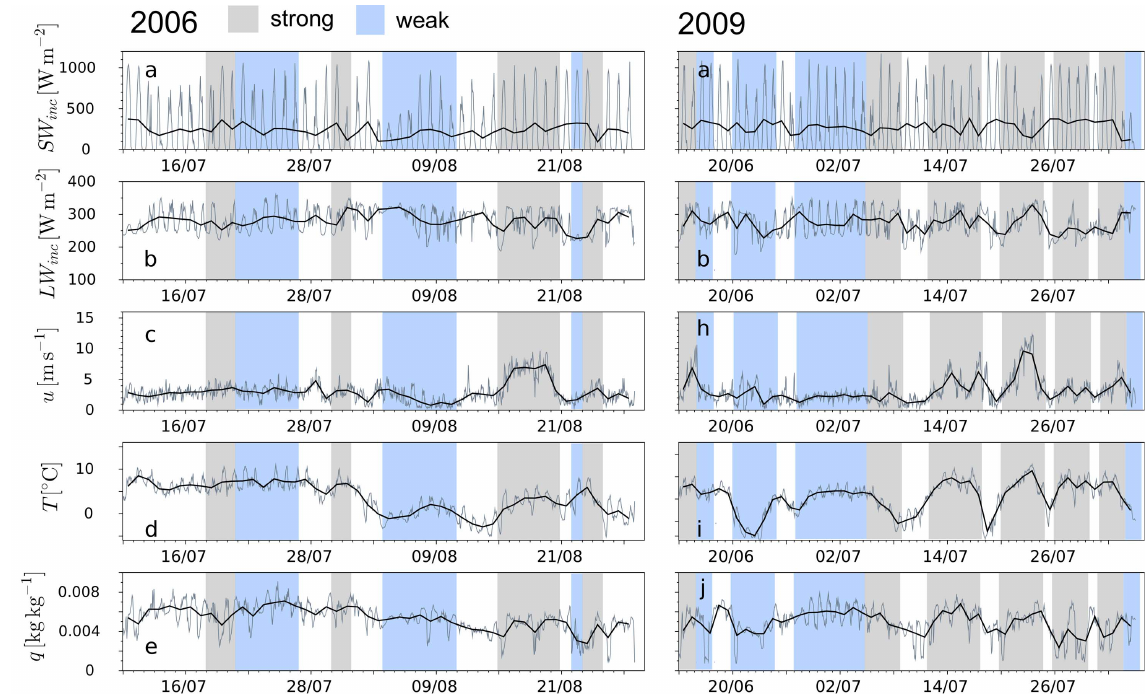
Figure 3. Change of the meteorological variables in the ablation zone of the glacier at the AWS-G in (left) 2006 and (right) 2009. (a, f) In- coming shortwave radiation, (b, g) incoming longwave radiation, (c, h) wind speed, (d, i) air temperature and (e, j) specific humidity of the air. SF conditions are dark shaded and WF conditions are blue shaded. The dark lines in lower panels (c, d, e, h, i, j) show daily